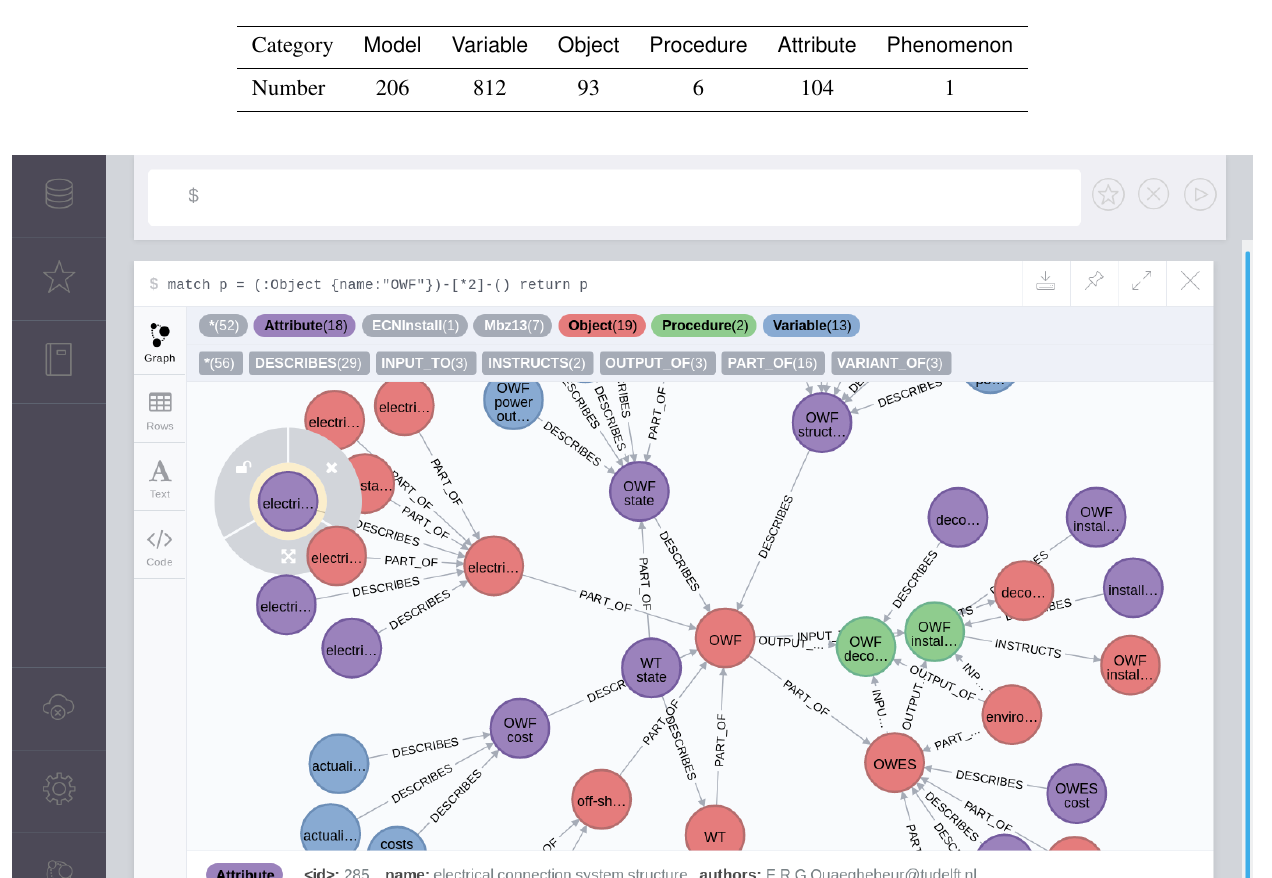
Table 3. Database content node category numbers.